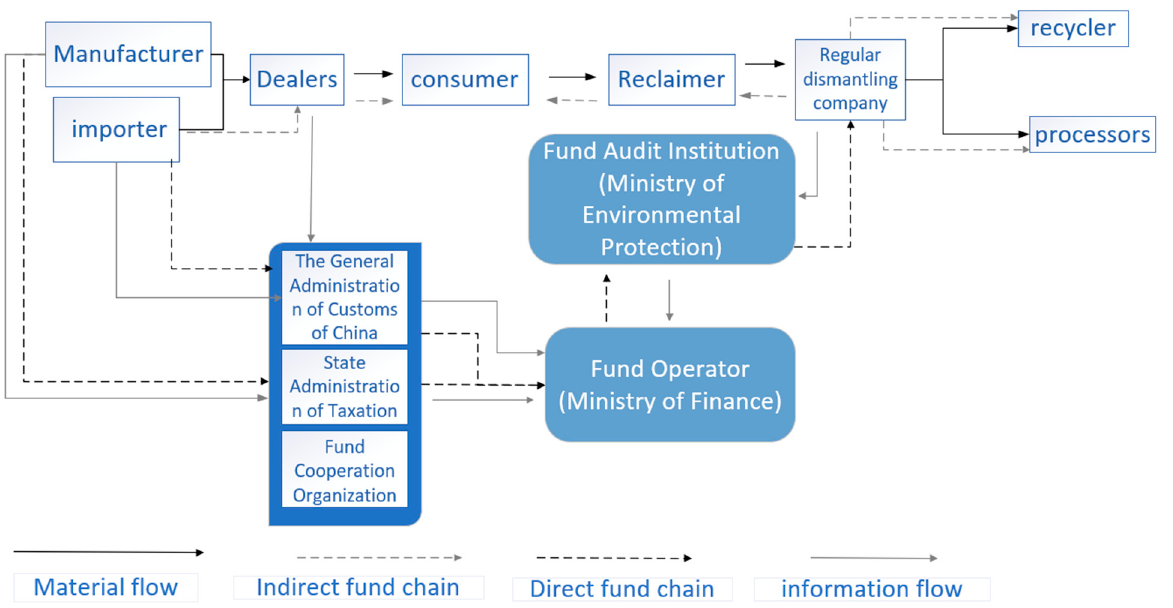
Figure 4. Operation mode of the fund policy in China (concluded from [44]).